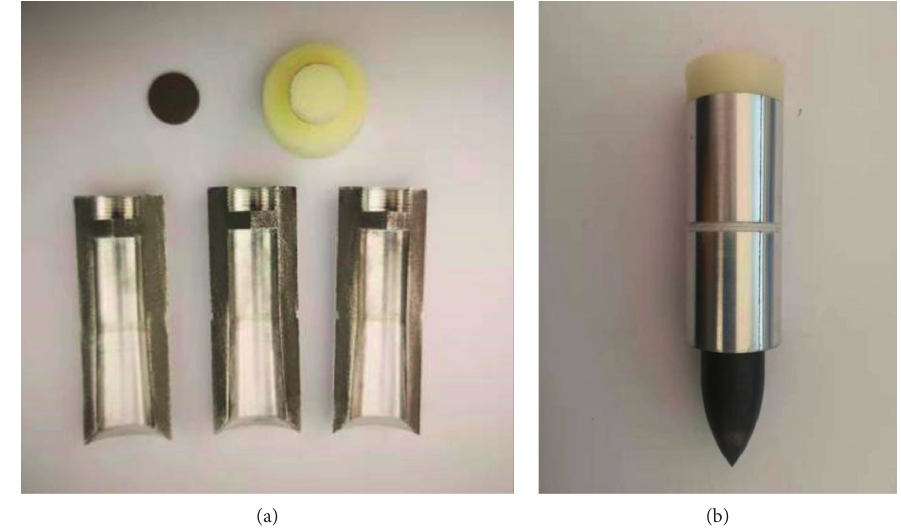
Figure 2: Aluminum sabot and loading configuration.